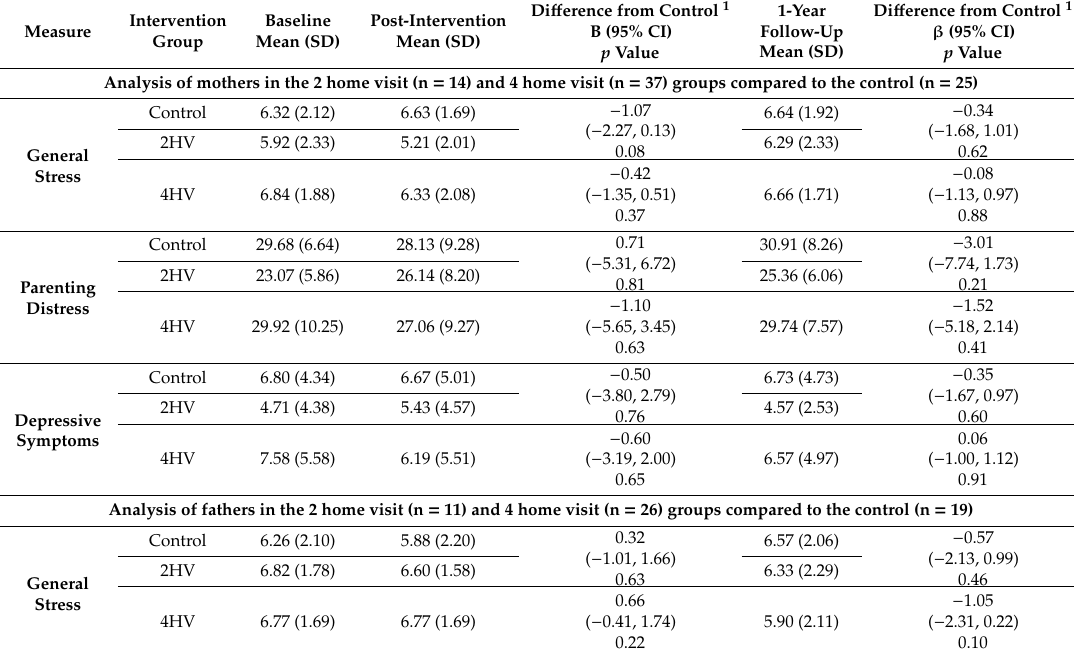
Table A1. Linear regression results comparing intervention (two home visit and four home visit groups) and control groups with respect to stress levels at post-intervention and at 1-year follow-up after controlling for baseline, stratified by parent gender. Household chaos model analysed at the family level (one observation per